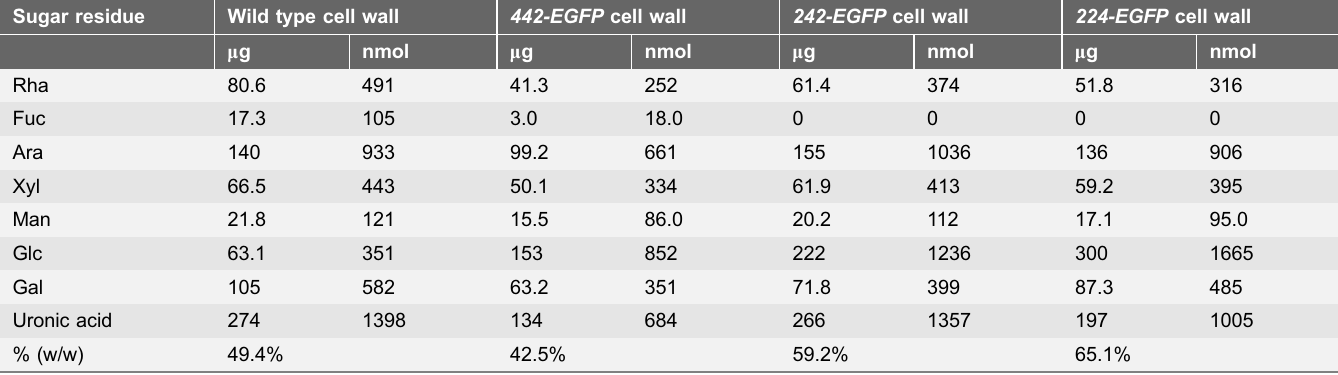
Table 6. Acid-hydrolysable sugar composition of cell walls. Sugar